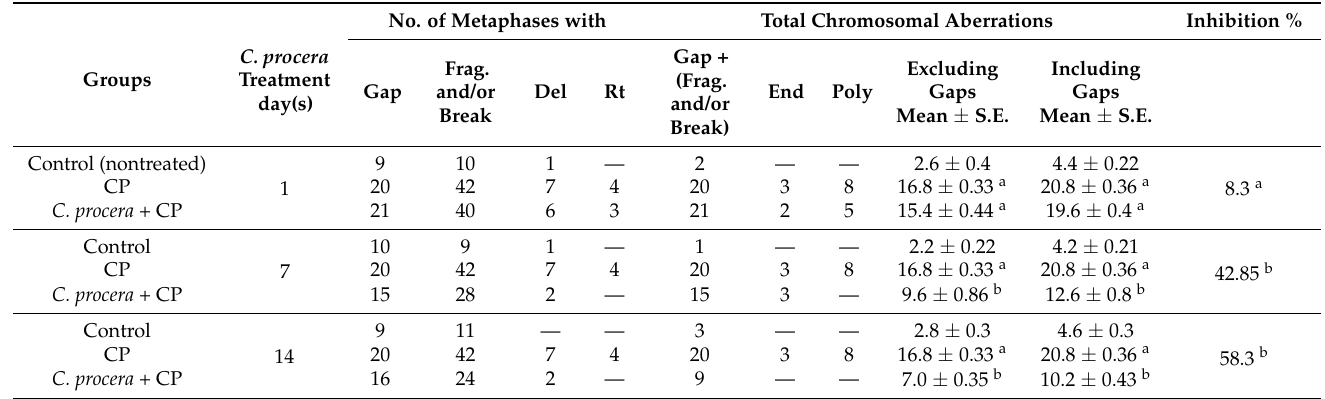
Table 5. Number and mean percentage of the different types of chromosomal aberrations in bone marrow cells of mice after treatment with C. procera 200 mg/kg for 1, 7, and 14 days alone or in combination with cyclophosphamide 20 mg/kg.